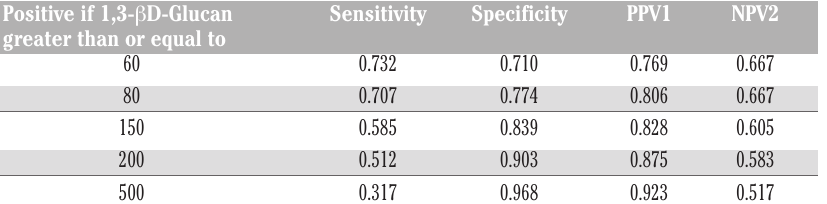
Table 3. Sensitivity, specificity and positive and negative predictive values at varying 1,3- b D-Glucan assay levels (n=72) Positive if 1,3- b D-Glucan